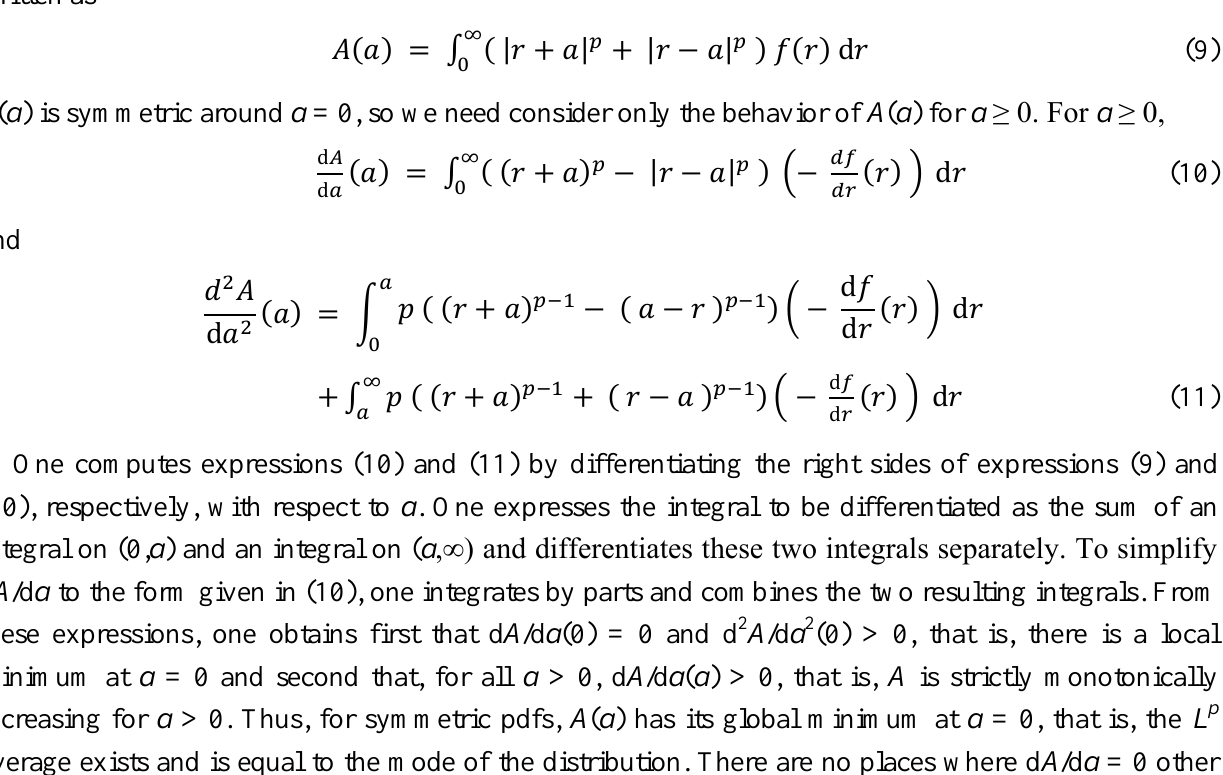
Algorithm 1 : Algorithm for l p